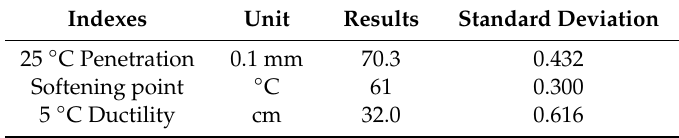
Table 3. Main technical indicators of SBS (Styrene-Butadiene-Styrene) modified